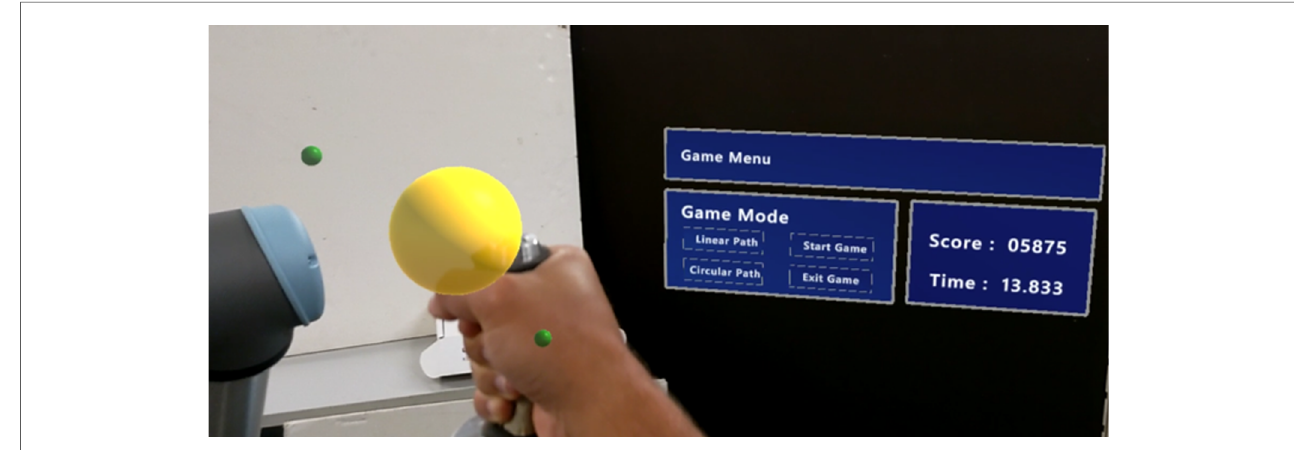
FIGURE 2 Participant prespective while using the system.